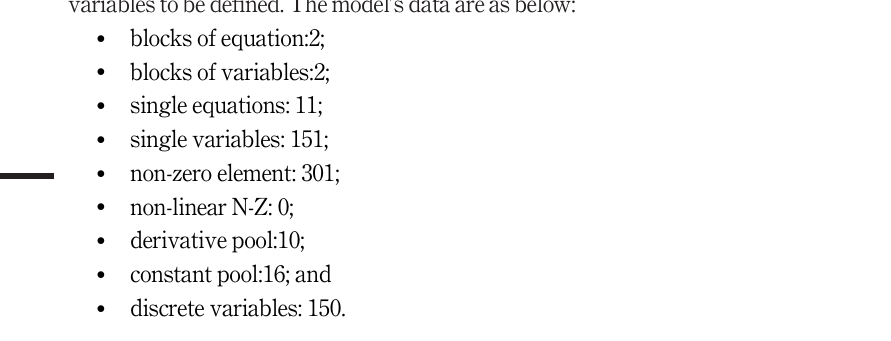
Figure 1. Comparison of the optimal functions of the two cuckoo algorithm and GA in the preparation stage